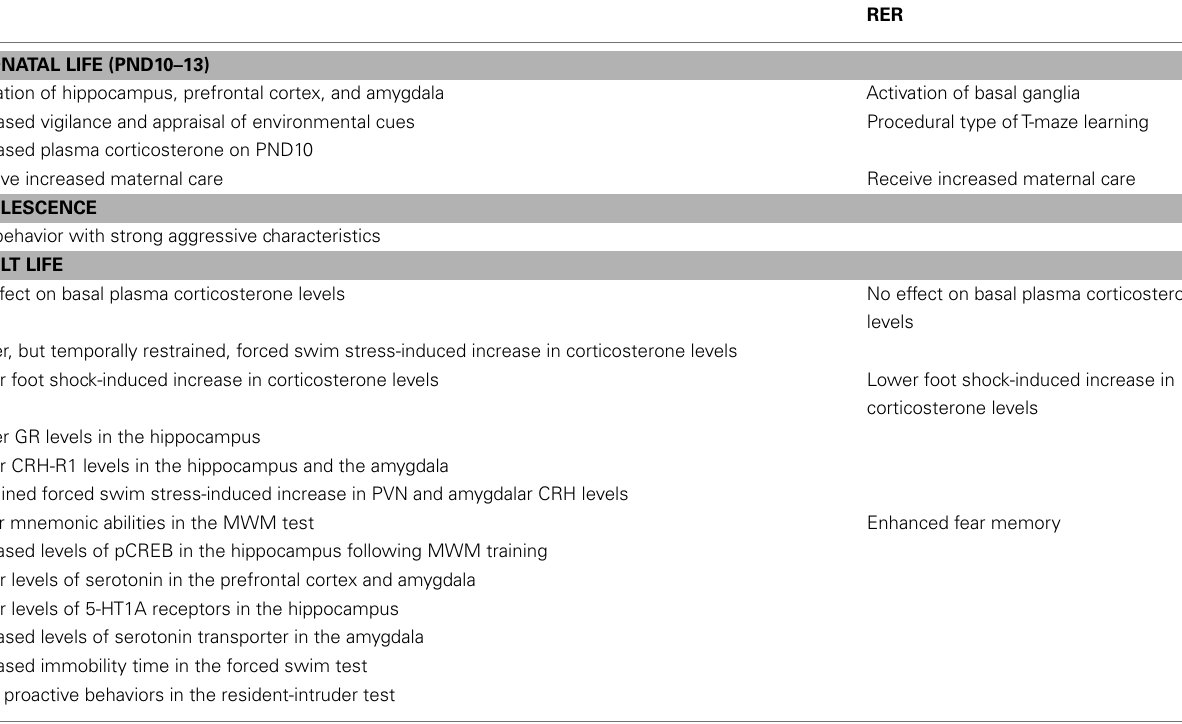
Table 1 | Effects of the DER and RER neonatal experience of our model in male rats – compared to controls.